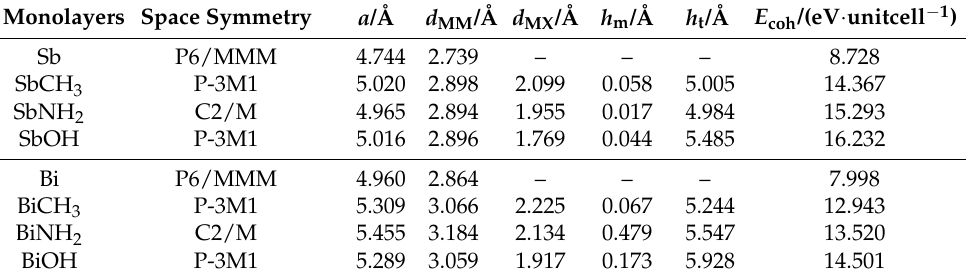
Table 1. Space symmetry, lattice constants a , chemical bonding lengths ( d MM and d MX : M = Sb, Bi; X = C, N, O), thicknesses of the internal Sb/Bi layer and the entire monolayer (vertical distances between two Sb/Bi atomic-planes h m and between the outermost two hydrogen atomic-planes on two surface sides h t ), and cohesive energy ( E coh ) of SbXH n and BiXH n compared to Sb and Bi monolayers.